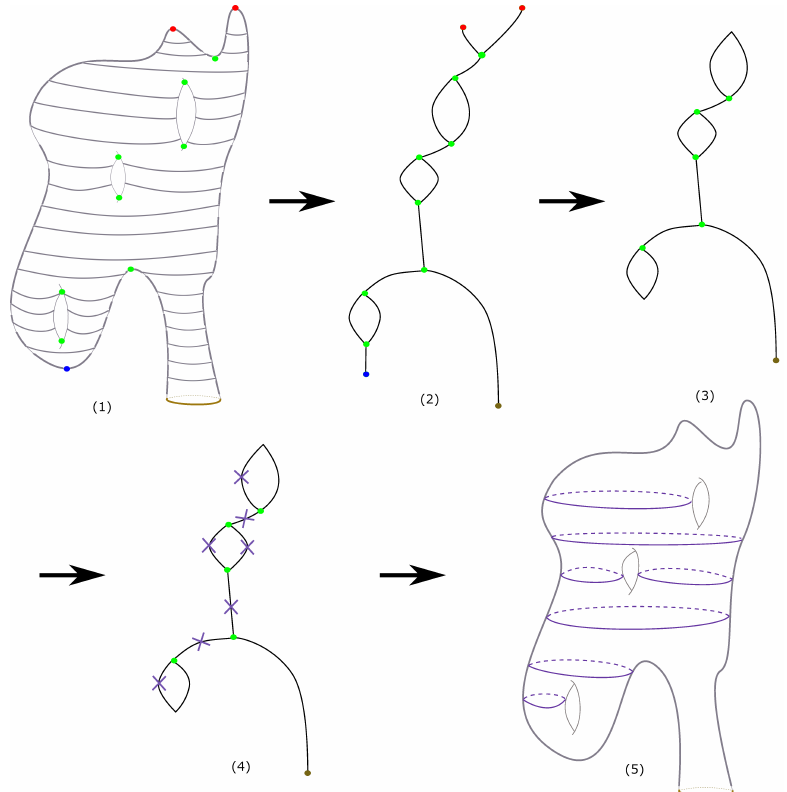
Figure 22. A Reeb graph can be used to segment a surface into a collection of topologically consistent patches. (1) The surface M , with a scalar function f , is given as an input. (2) The Reeb graph of R ( M , f ) is calculated. (3) The deformation retract graph R (cid:48) ( M , f ) of the graph R ( M , f ) is calculated. (4) For each edge in the graph R (cid:48) ( M , f ) , we select a point. (5) We select the curves on the manifold M that corresponds to the points that were selected in the previous